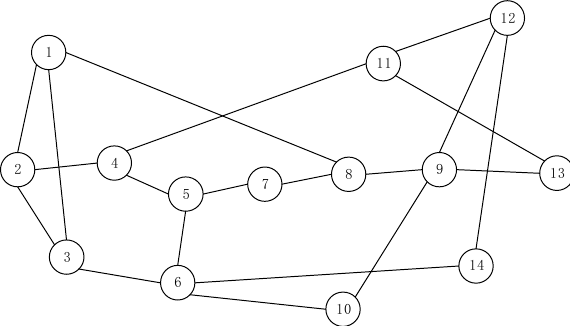
Figure 3. NSFNET topology used for simulation.